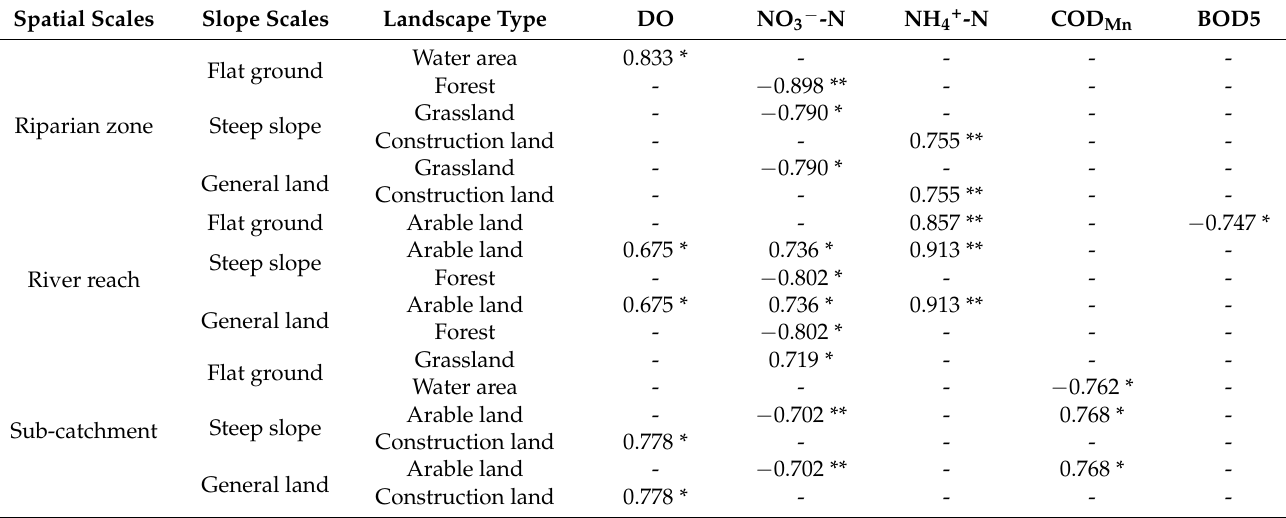
Figure 5. Spatial distribution of water quality nutritional indicators. Note: the numbers 1–8 are the code of surface water monitoring station. Table 2. The correlation between landscape type and RWQ in different